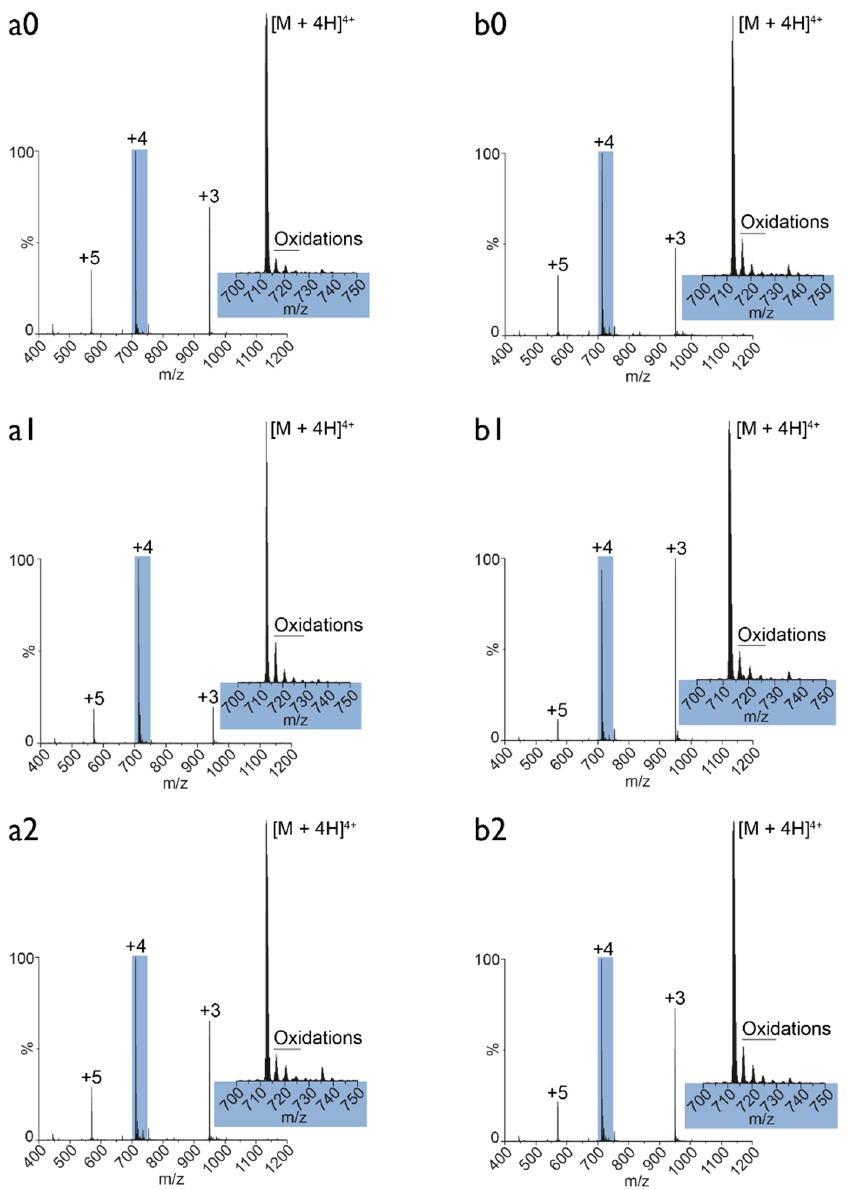
Figure 8. Native mass spectrometry (MS) of MEL. The Figure shows an overview of native MS spectra of MEL solubilized either in ( a ) untreated or ( b ) plasma-treated PBS buffer after different time points of incubation (0: 1 min; 1: 60 min; 2: 120 min). The inset in each spectrum displays the m / z region from 700 to 750 (zoom-in of the [M + 4H] 4+ species). The satellite peaks highlighted in the insets correspond to oxidations of MEL.